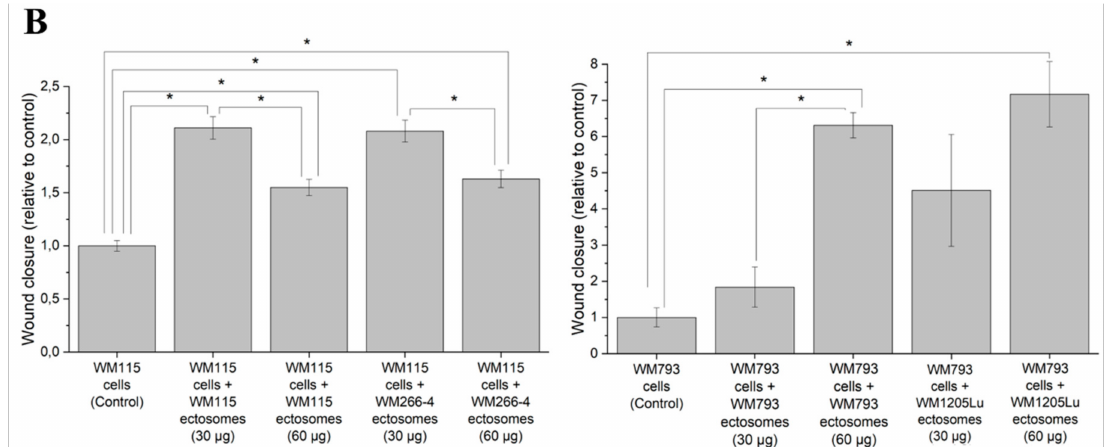
Figure 6. E ff ect exerted by self-derived ectosomes and ectosomes released by their isogenic metastatic cells, on the motility of primary WM115 and WM793 cells. Wound healing assay was performed after 18 h of incubation with ectosomes. ( A ) Representative images were taken at 0 h and at 18 h. ( B ) Graphs presenting relative velocity of wound closure calculated from three repetitions. “*” denotes statistically significant di ff erences (Tukey’s post-hoc test, p value < 0.05).